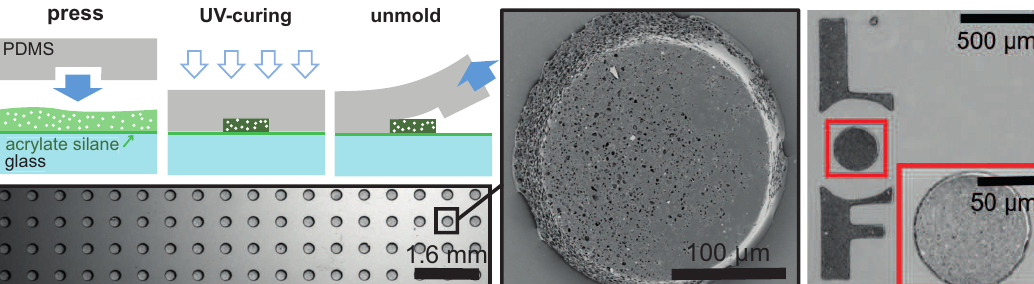
Figure 9. Sketch of the soft embossing process with a PDMS stamp designed with micro-cavities, here cylindrical cavities on a square lattice. The stamp squeezes the formulation in the cavities and may lead to well defined patterns on a substrate after UV-curing and acidic treatment. The pictures show a small part of the patterned substrate and a magnification on one cylinder, and also the logo of our lab (LOF) soft-embossed the same way.